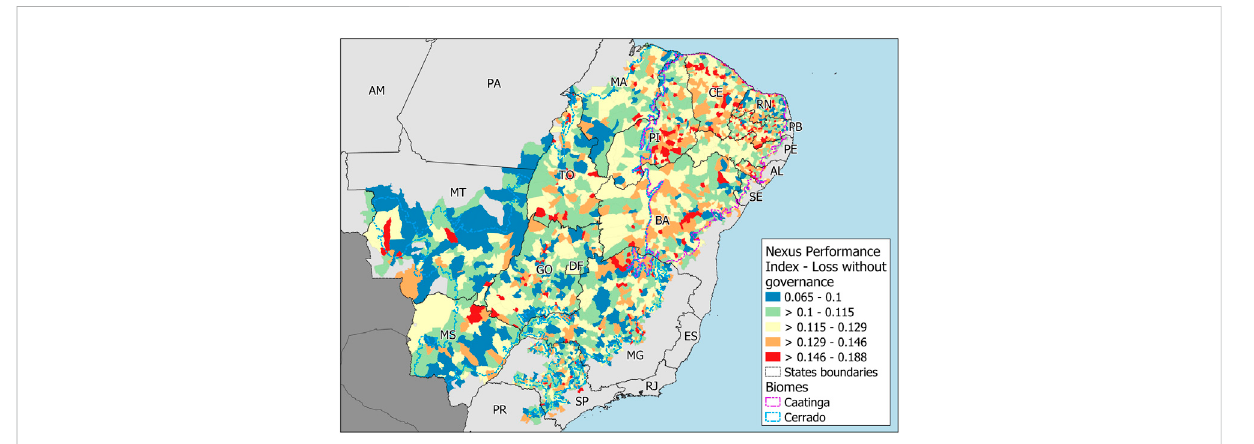
FIGURE 9 Sensitivity analysis of governance indicators for the NPI.